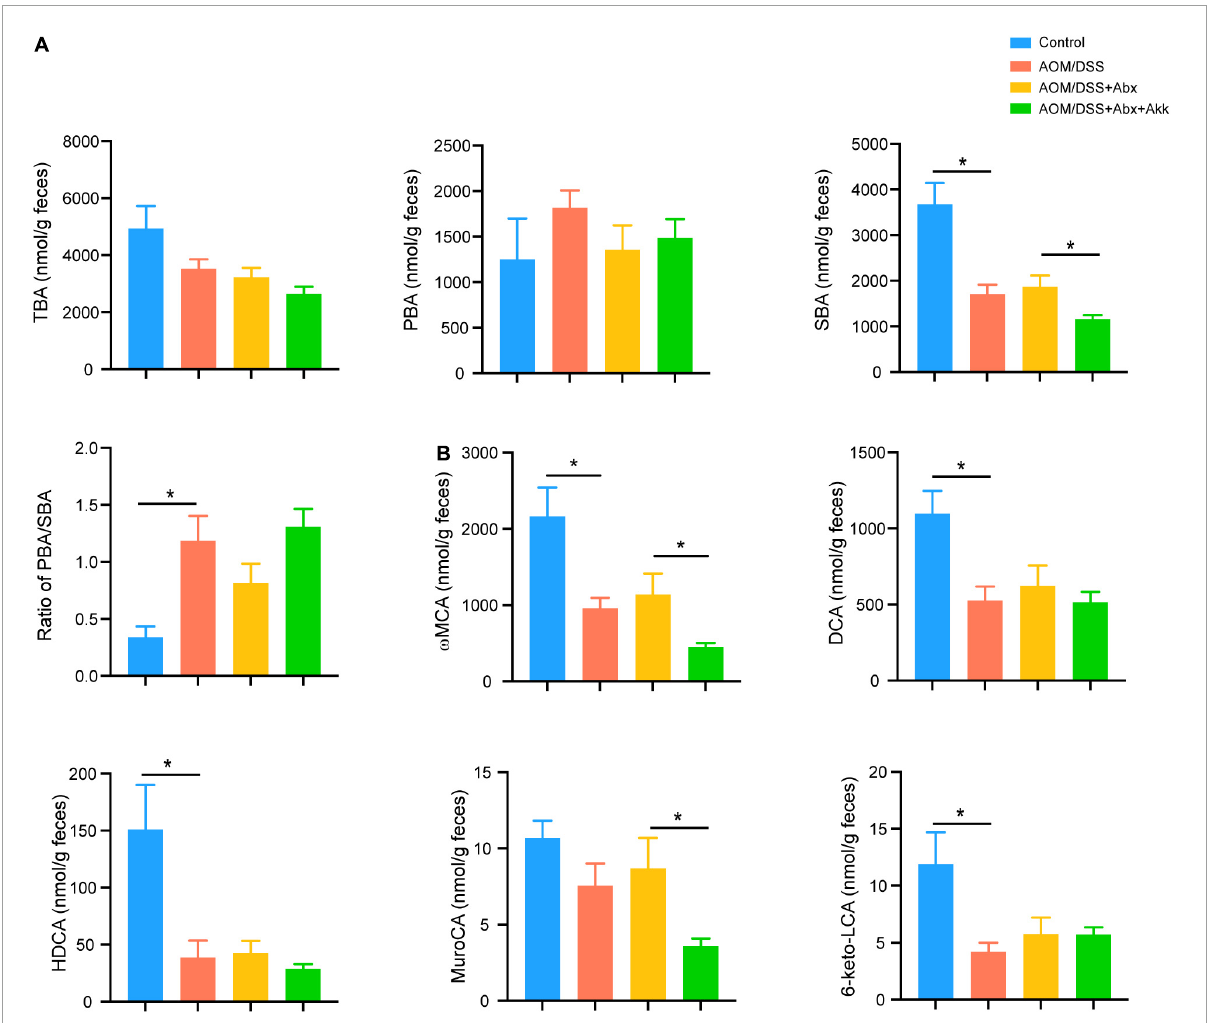
FIGURE7 Akkermansia muciniphila administration impacted BA metabolism in the development of CAC. (A) Fecal levels of TBA, PBA, and SBA, and ratio of PBA/SBA in the four groups (week 12). (B) Levels of ω MCA, DCA, HDCA, muroCA, and 6-keto-LCA in the four groups. Data are shown as means ± SEM. * P <